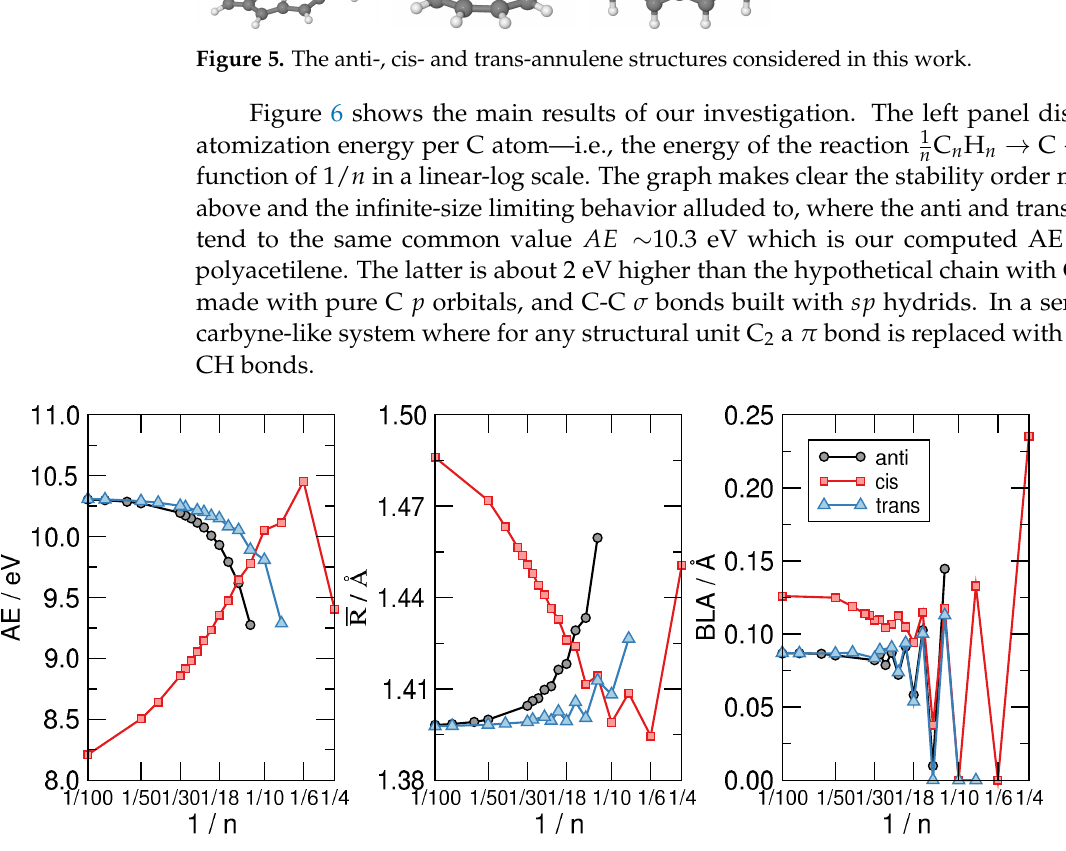
Figure 6. From left to right: The atomization energy per C atom ( AE ), the average CC bond length ( ¯ R ) and the bond length alternation (BLA) for the C n H n structures exemplified in Figure 5, as functions of 1/ n , on a linear-log